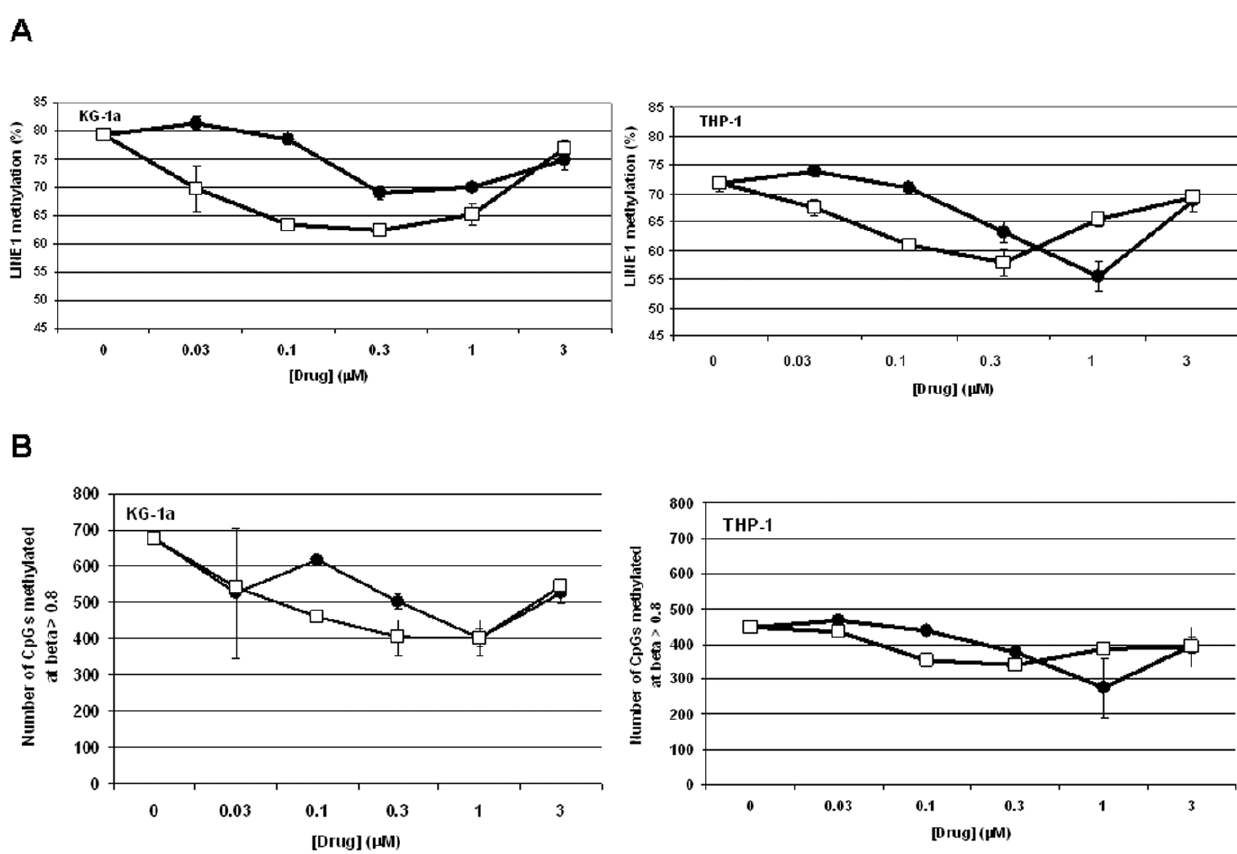
N ) or DAC ( % ) (0–3 m M) for